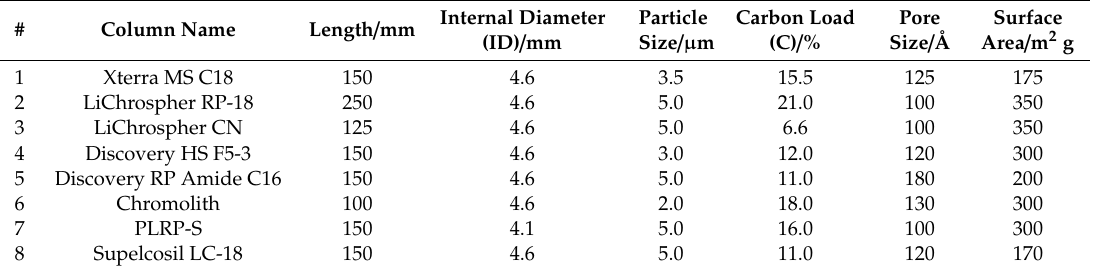
Table 2. Key physicochemical parameters of the evaluated chromatographic